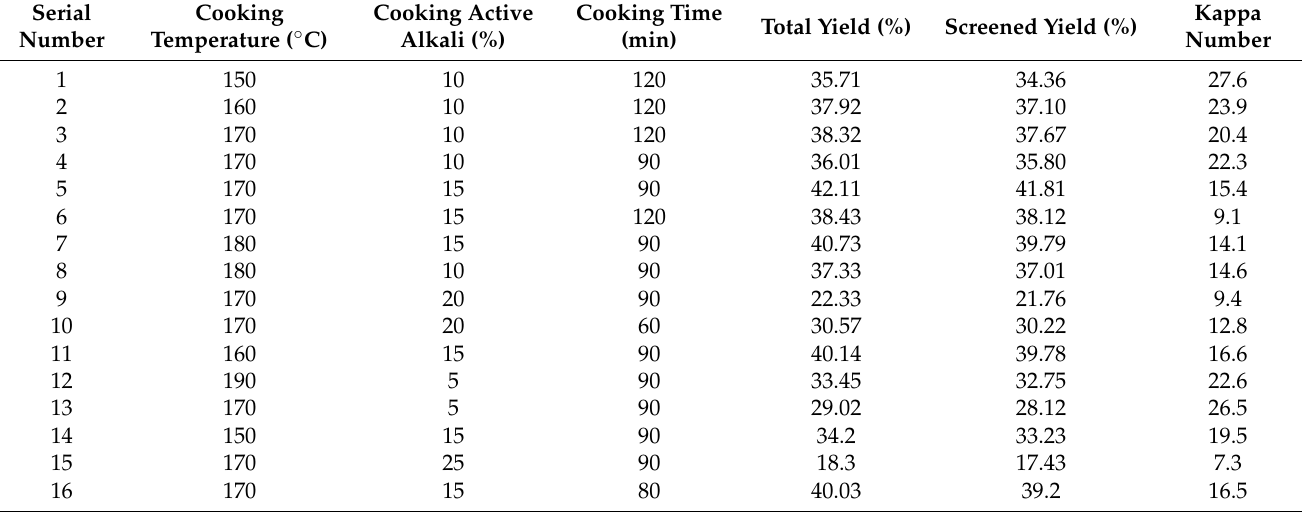
Table 3. Cooking temperature for Kraft pulping of M. azedarach , with sulfidity at